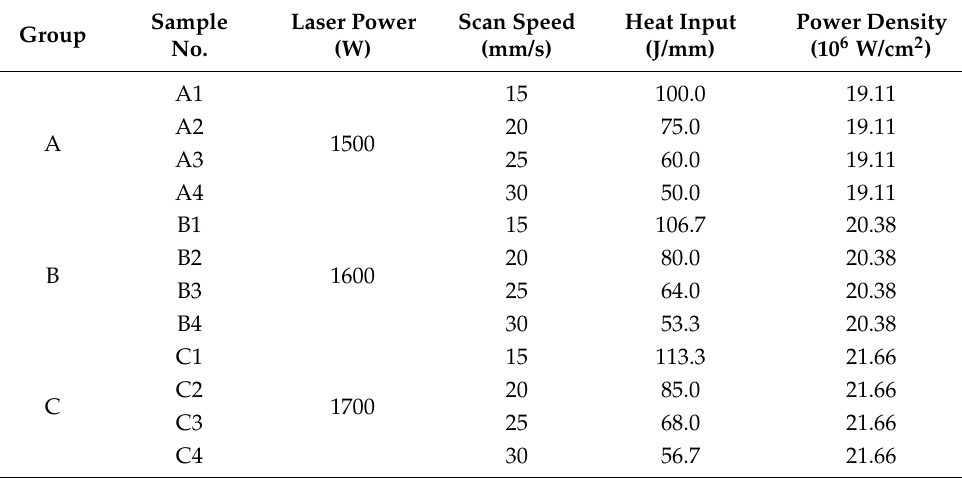
Table 2. Laser process conditions used in the experiment.